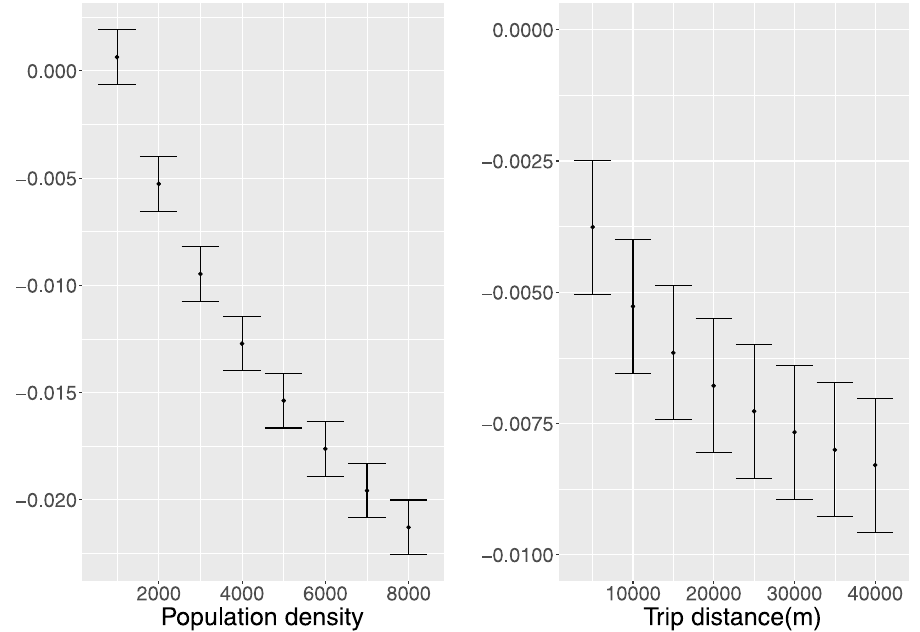
Fig 7. Total marginal effects of infection cases ( IFC ). Population density and trip distance are fixed to 2000 and 10km when the other variable is changed.